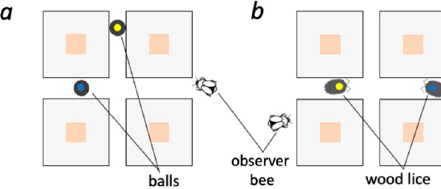
Figure 2. Bumblebees do not simply attend to the color cues in a novel scenario. ( a , b ) After two new groups of bumblebees were trained on the horizontal wall situation (Figure 1a), they were then tested in a novel context featuring two demonstrators, either small wooden balls ( a ) or a non-nectivorous species (woodlice; b ). In this novel situation, the balls were moved via internal magnets and magnets under the arena floor. The woodlice roamed around the arena floor